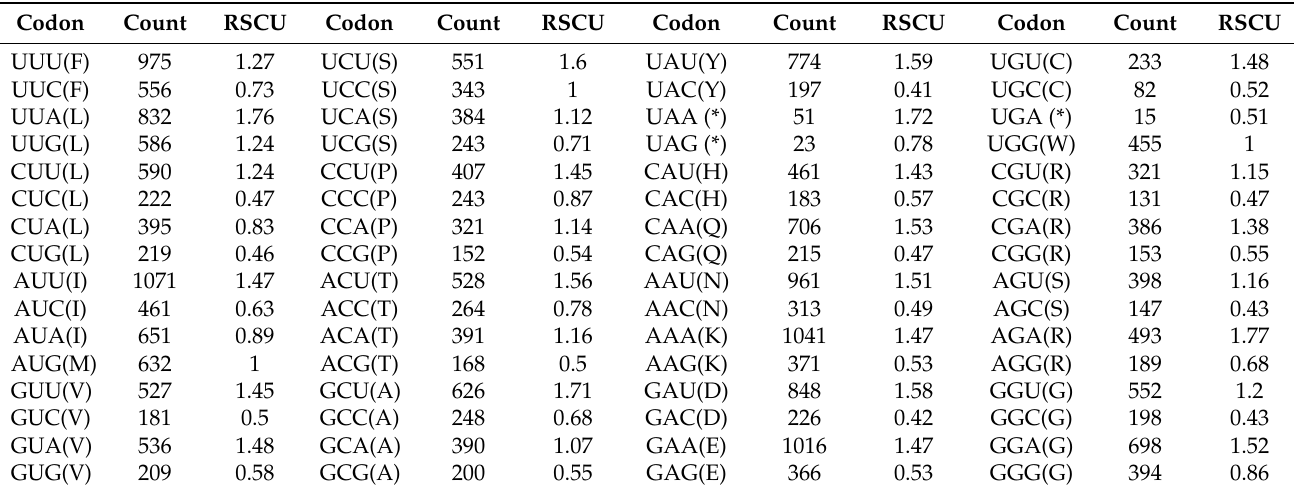
Table 3. Analysis of relative synonymous codon usage (RSCU)in Fortunella venosa chloroplast